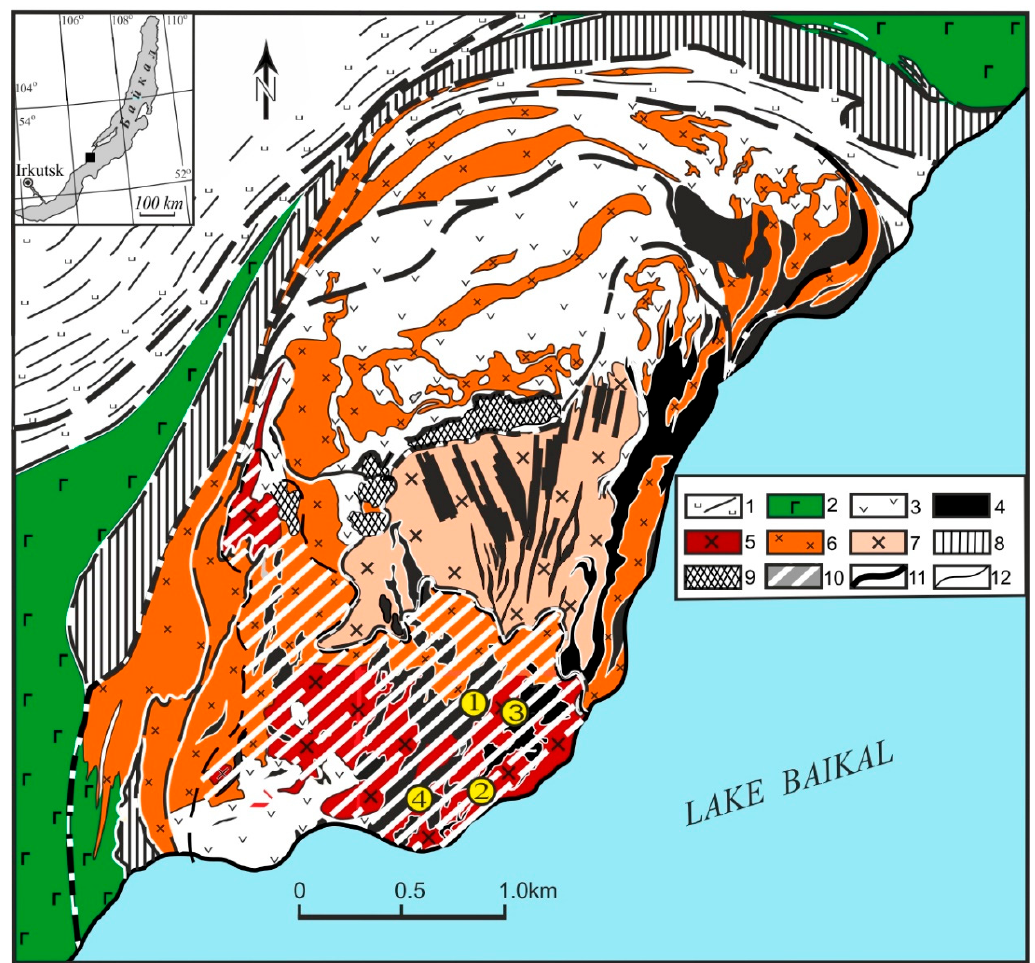
Figure 3. Geological sketch map of the Tazheran Massif, modified after [24]: 1–2 = country rocks: Amphibolite, silicate–carbonate gneiss (1); metamorphosed gabbro, monzogabbro, monzonite, syenite, 500 Ma (2); Tazheran Massif, 460–470 Ma (3–7): beerbachite after tholeiitic dolerite and gabbro (3), subalkaline gabbro and microgabbro (4), nepheline syenite (5), foliated (6) and massive (7) syenites; 8–10 = zones of metasomatic rocks of calcic (8), alkaline (9), and magnesian (10) types; 11 = synmetamorphic ductile detachment; 12 = geological boundaries.